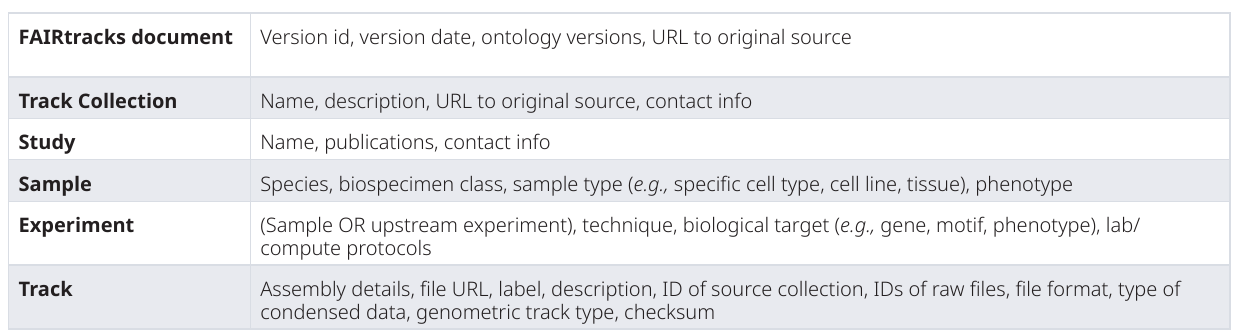
Table 2. Key attributes of FAIRtracks objects. FAIRtracks document